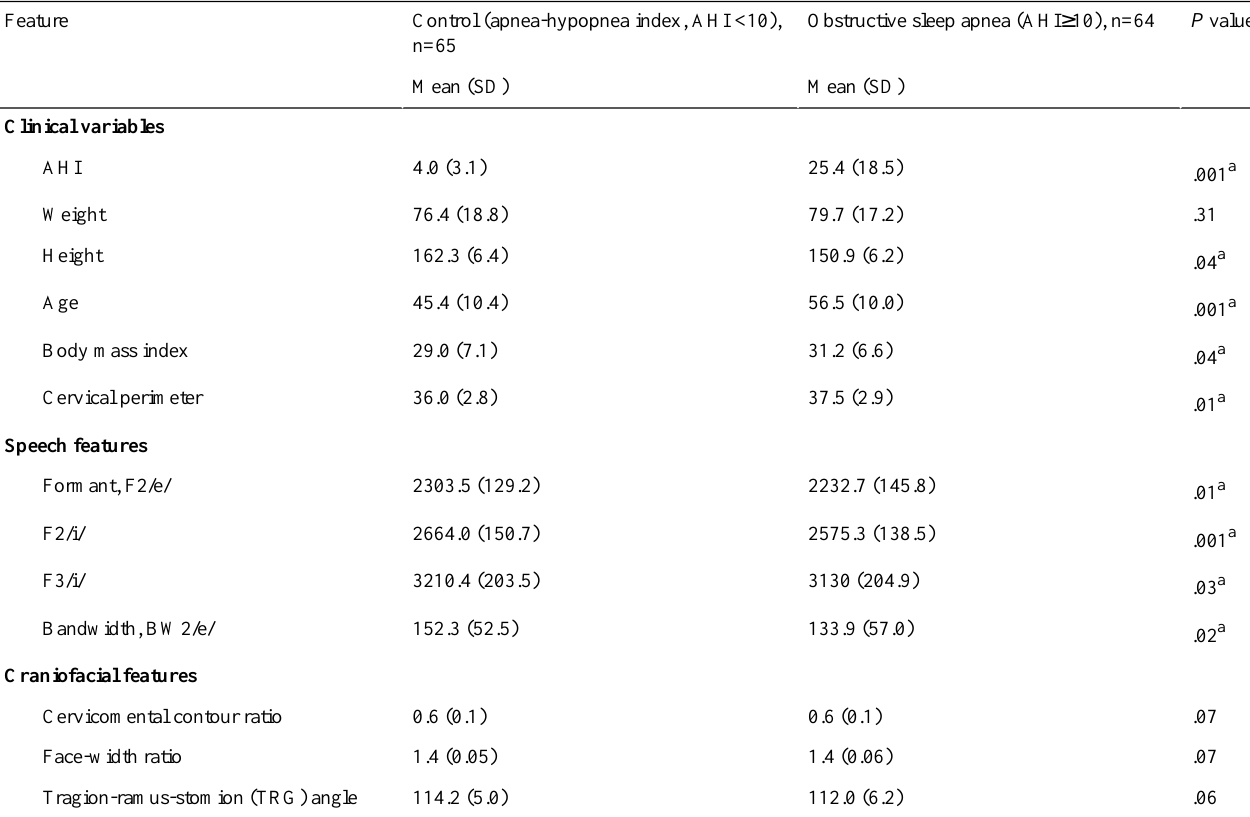
Table 8. Contrast among control and obstructive sleep apnea (OSA) severity groups on the female population